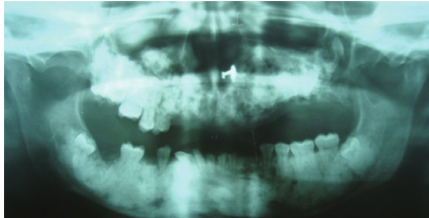
Figure 9: Extraoral photograph of patient’s mother (Case 2).